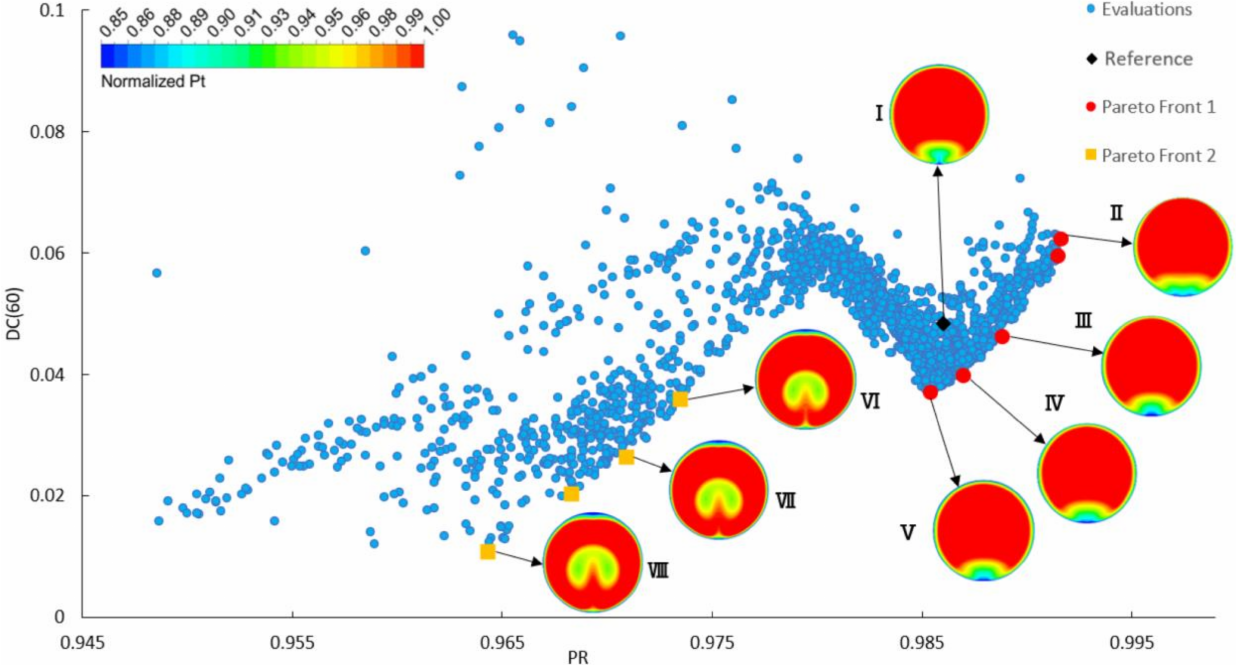
Figure 18. Evaluation history of the centerline deformation optimization with illustrations of the normalized total pressure distribution for a subset of the Pareto optimal